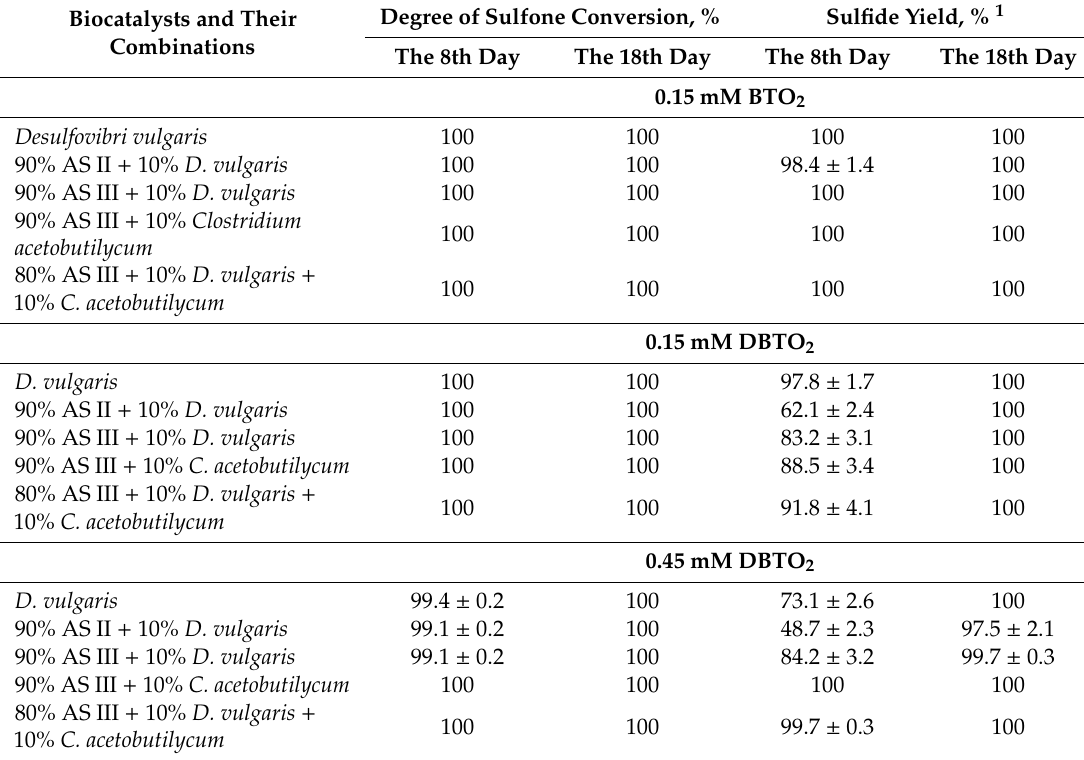
Table 2. Parameters of organic sulfones bioconversion to sulfide under the action of di ff erent biocatalysts immobilized in the PVA cryogel. Biocatalysts and